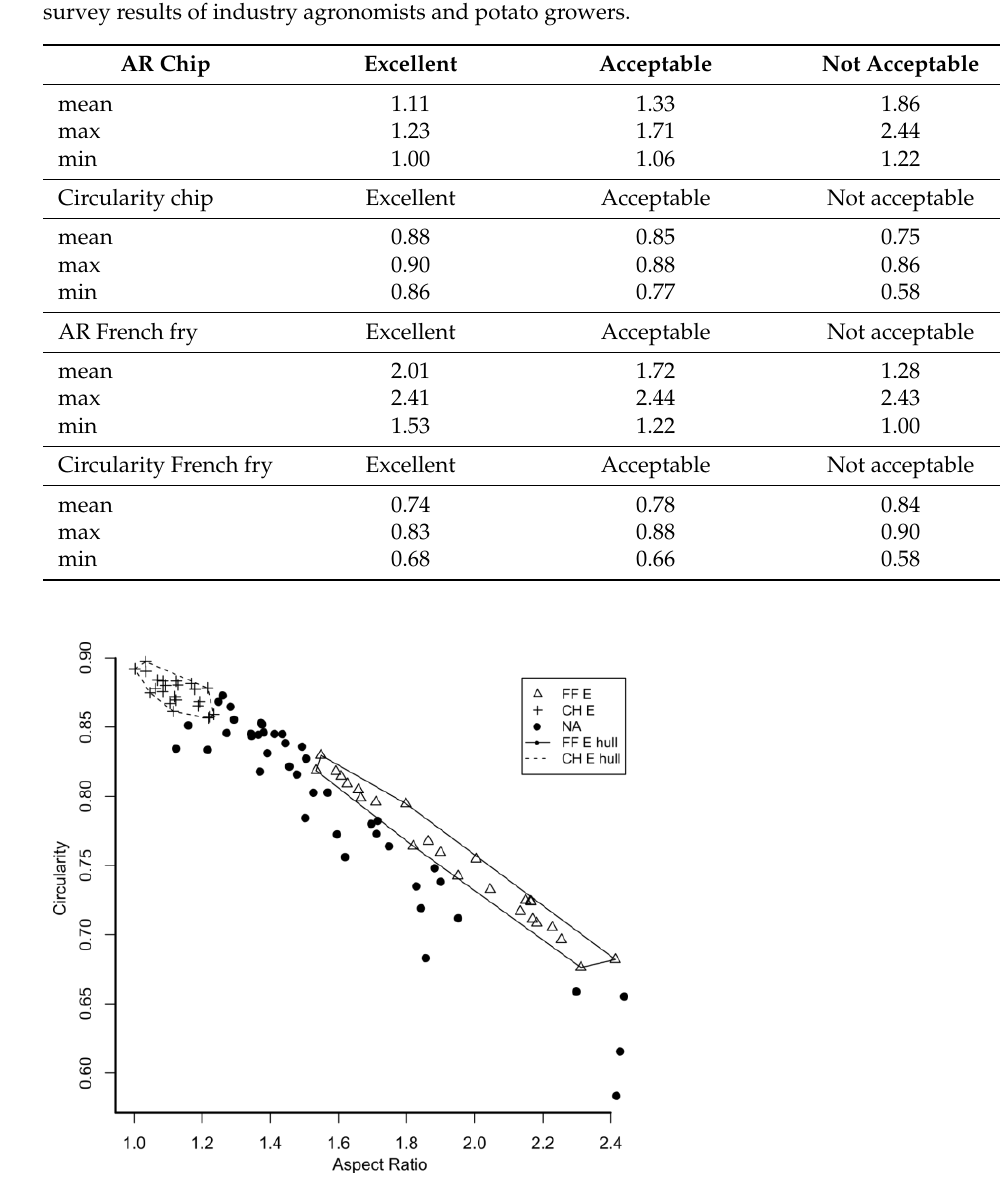
Figure 5. Survey results for tuber classification. Images of tubers were sent to industry stakeholders and ranked based on shape for the French fry and chip markets. FF E: French fry Excellent. CH E: Chip Excellent. NA: Not Acceptable (for either French fry or chip). Polygons represent boundaries for Excellent French fry and chip market shape.